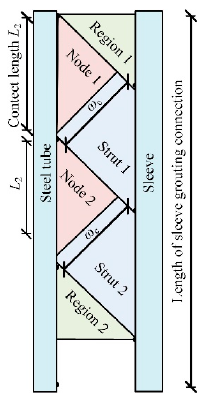
Figure 9. Sleeve grouting connection of the staggered arrangement of shear keys.